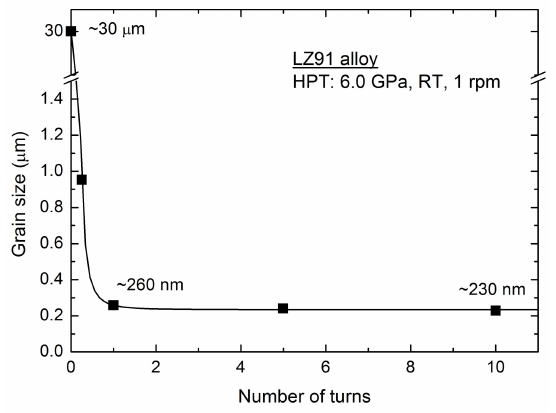
Figure 5. Average grain size of LZ91 alloy before and after HPT processing with increasing torsion